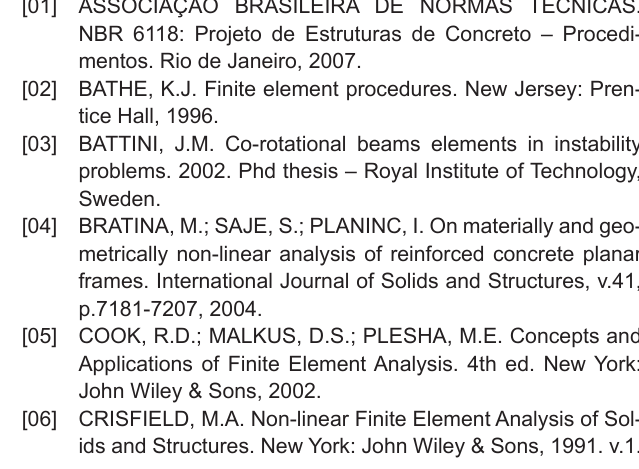
Figure 9 – Load-displacement c urves of the concrete